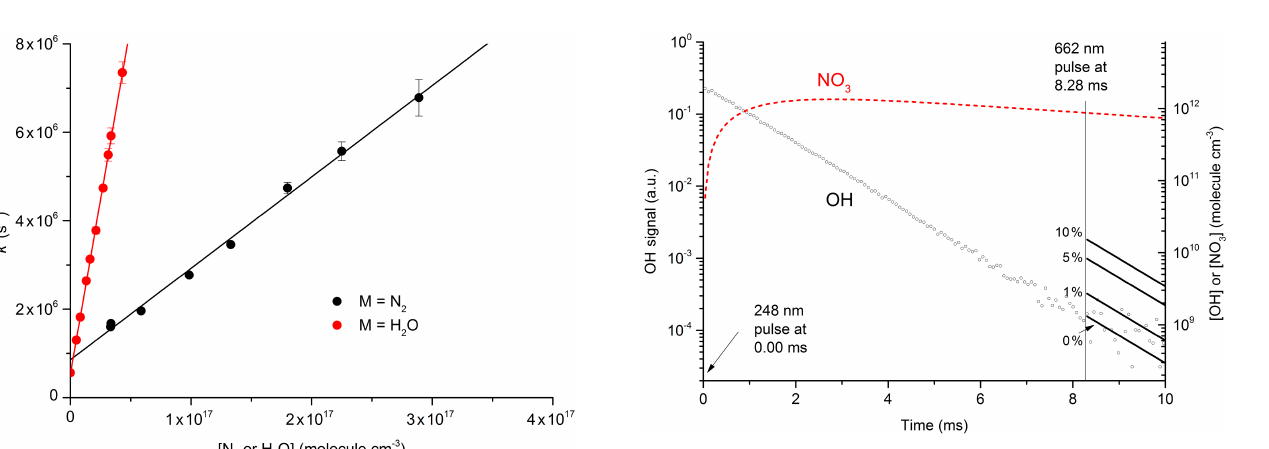
Figure 6. Plots for the determination of total quenching rate co- efficients for NO ∗ with N 2 (Reaction R10) and with H 2 O (Reac- 3 tion R12) at 296K: k 10 = ( 2 . 1 ± 0 . 1 ) × 10 − 11 cm 3 molecule − 1 s − 1 ; k 12 = ( 1 . 6 ± 0 . 3 ) × 10 − 10 cm 3 molecule − 1 s − 1 . The error bars are statistical uncertainty (2 σ ) from the fits to OH decays as exempli- fied in Fig. 5.